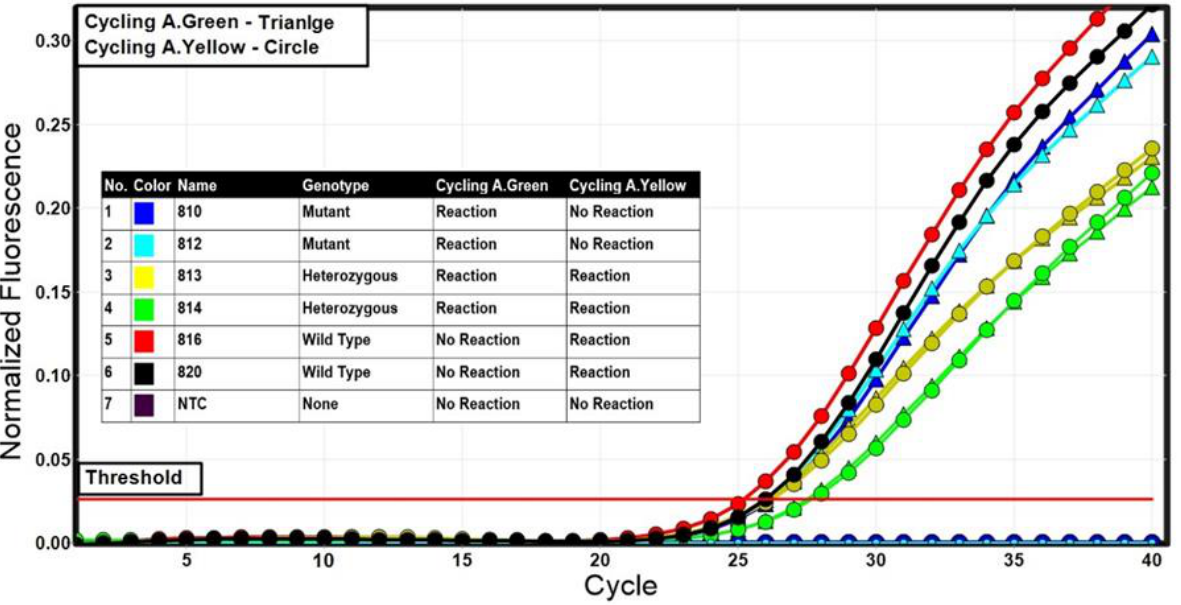
Figure 1. Allelic discrimination of the A1 and A2 alleles for the bovine CSN2 gene with dual-labelled probes. ( A ) genotype A1A1, ( B ) genotype A1A2, ( C ) genotype A2A2, ( D ) representative result for all three genotypes.